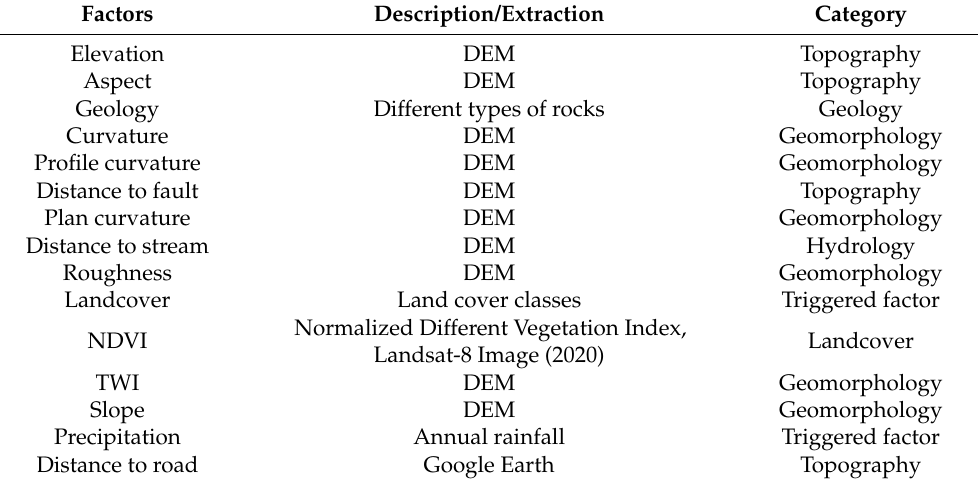
Table 1. The factors, description/extraction, and categorization of input